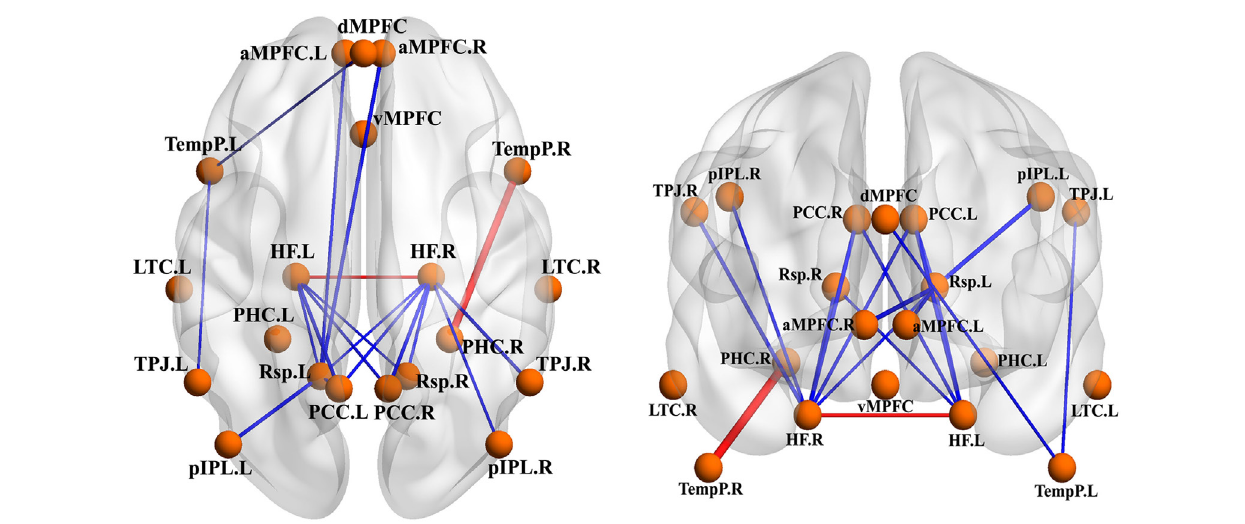
FigUre 2 | Abnormal functional connectivity (FC) within the default mode network (DMN) between patients with obstructive sleep apnea (OSA) and good sleepers (GSs). The blue edges represent decreased FC in patients with OSA compared to GSs and the red edges represent increased FC within the DMN. Undirected edges correspond to t -values, with a larger t -value corresponding to a thicker edge ( p < 0.05,